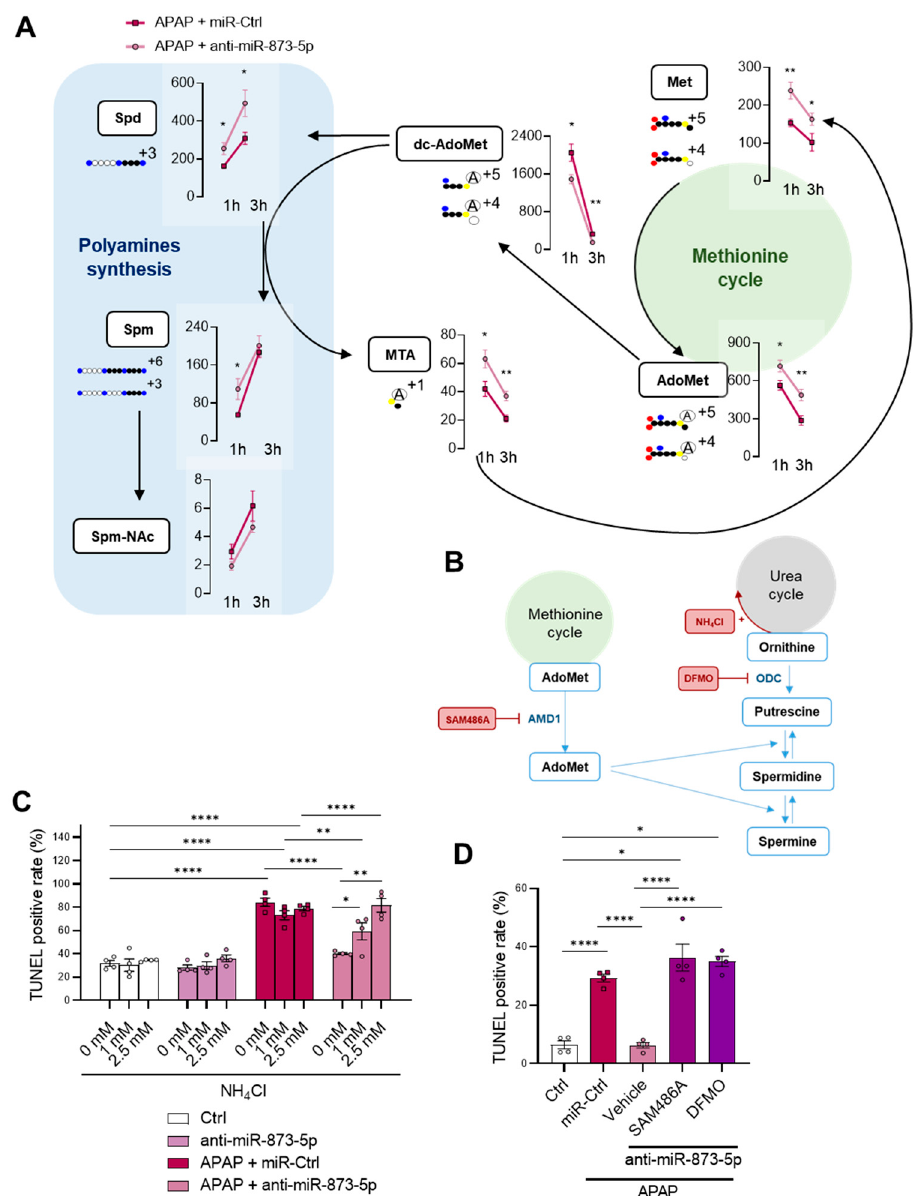
Figure 6. Methionine cycle recovery rewires nitrogen homeostasis from urea cycle to polyamine synthesis. ( A ) Schematic representation and determination of metabolites from methionine metabolism